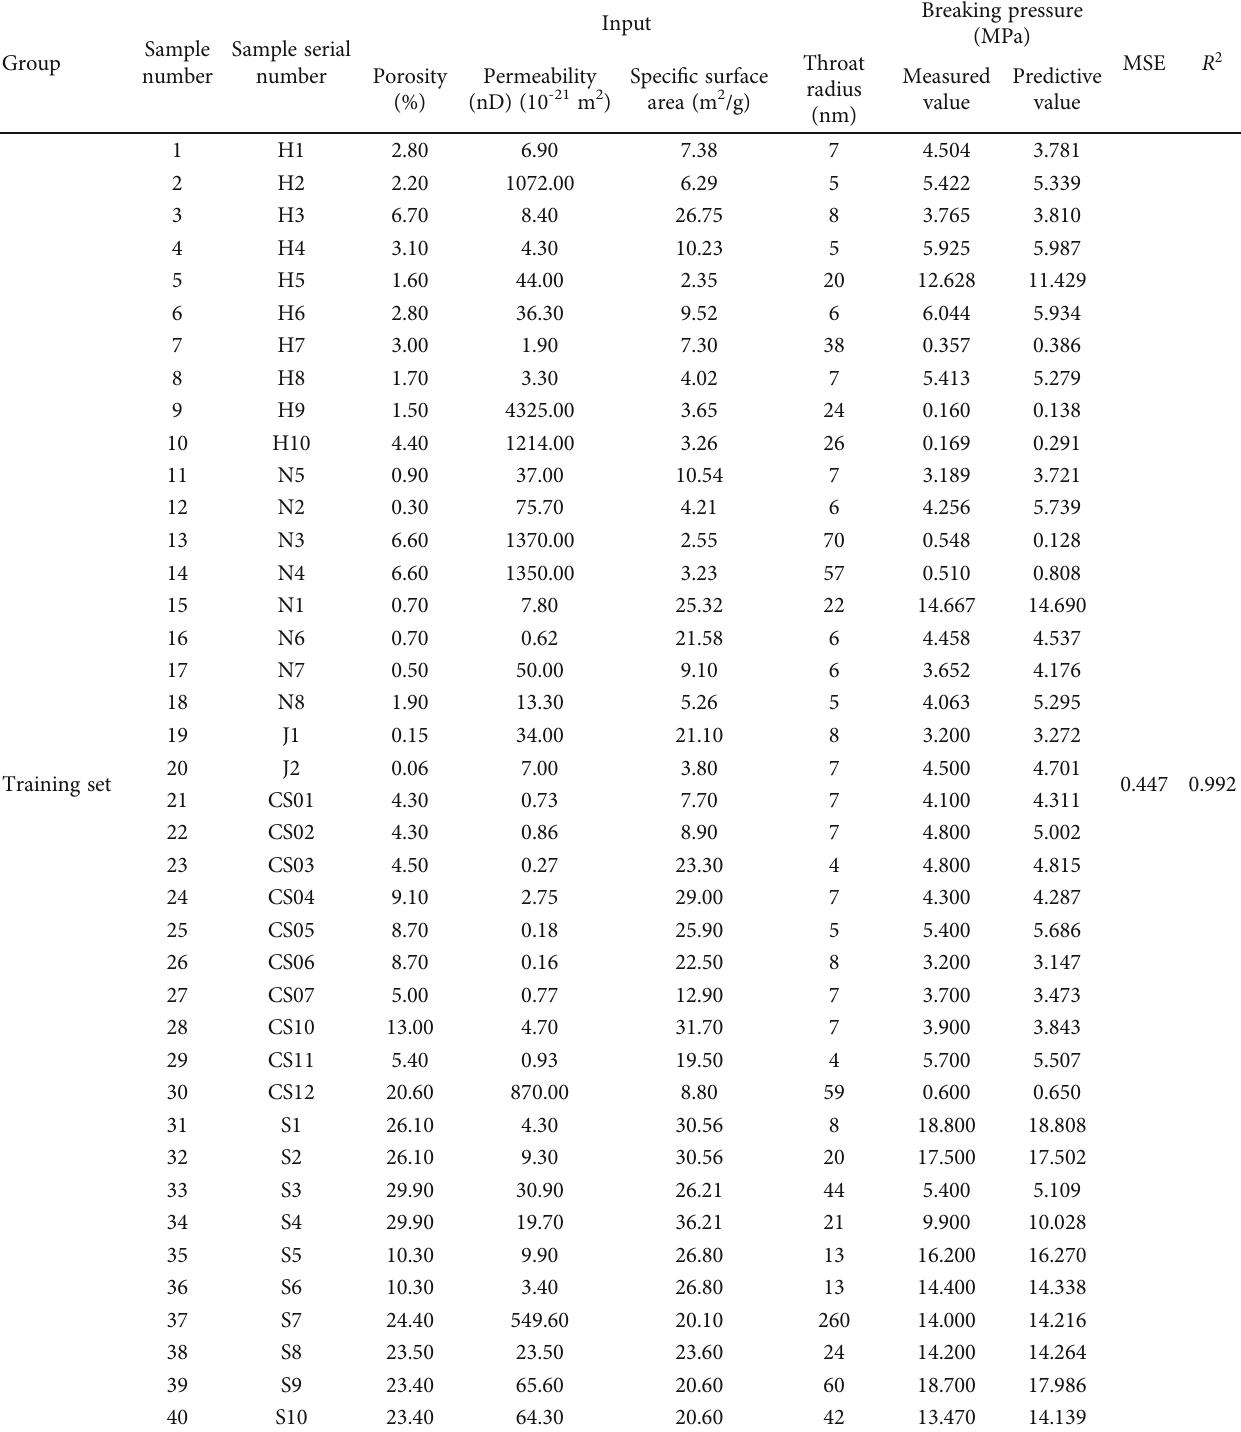
Table 2: Measured and predicted breakthrough pressures and other input and output data.